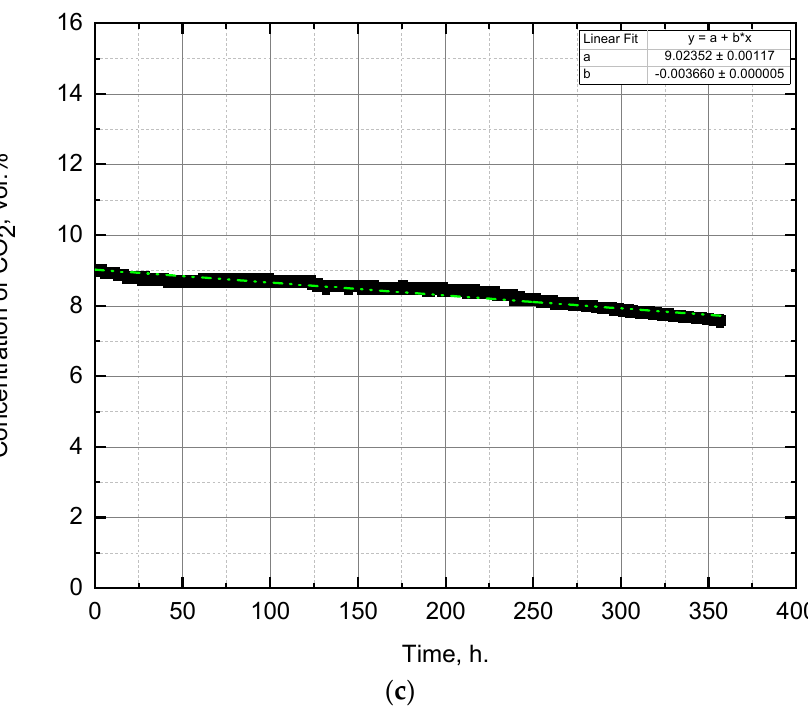
Figure 3. Change of CO 2 concentration during the experiment with the initial CO 2 concentration of: ( a ) 1 vol.%, ( b ) 5 vol.%, ( c ) 9 vol.%.